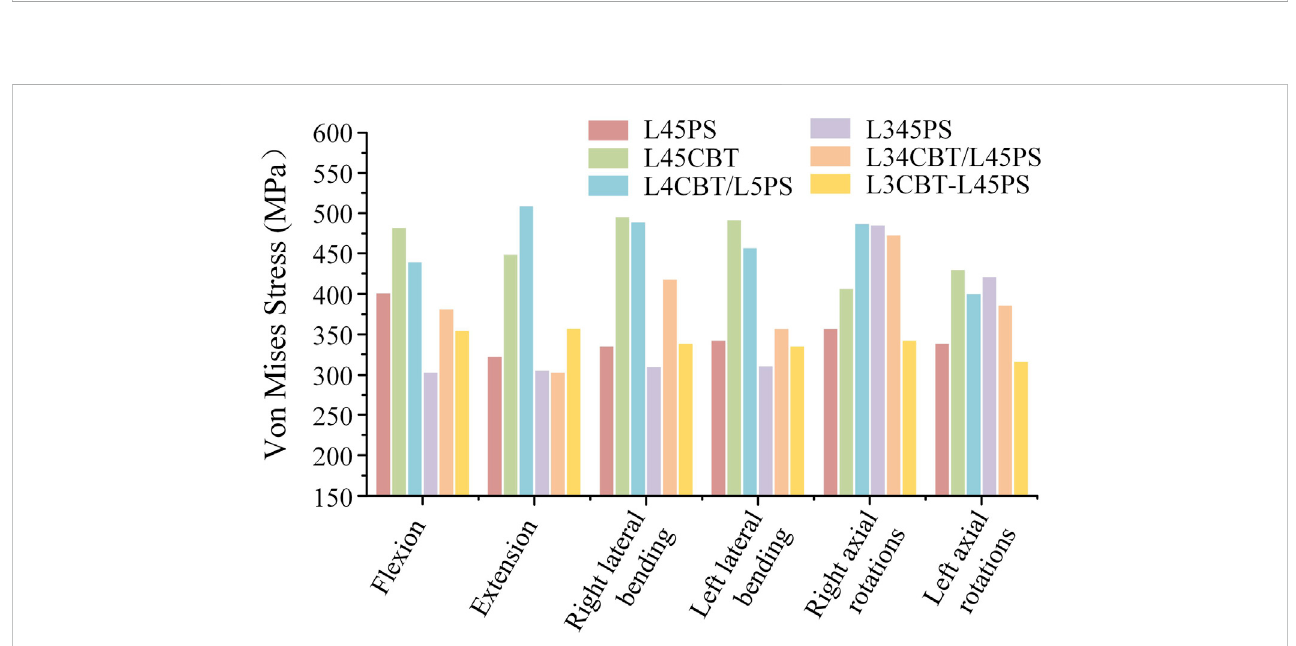
FIGURE 8 The stress value of screw – rod systems in six postoperative FEMs under different